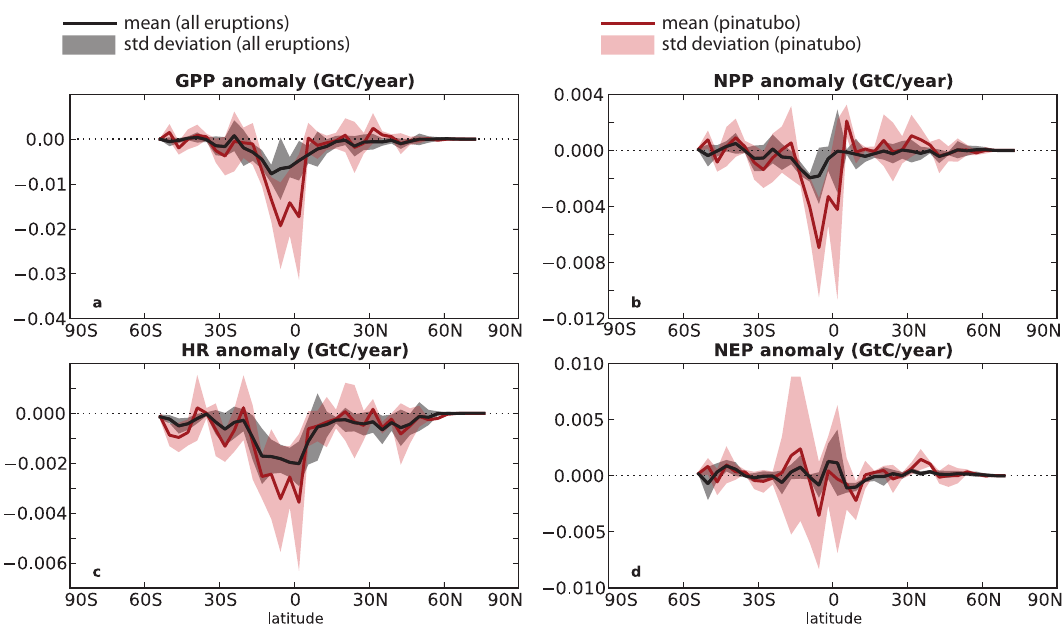
Fig. 7. Zonal mean anomalies in factors contributing the uptake of CO 2 from the atmosphere, computed by using the volcano anomaly method for Pinatubo (red) and the mean of several eruptions (black), averaged over the two years following the eruption(s). The shaded area represents one standard deviation above and below the